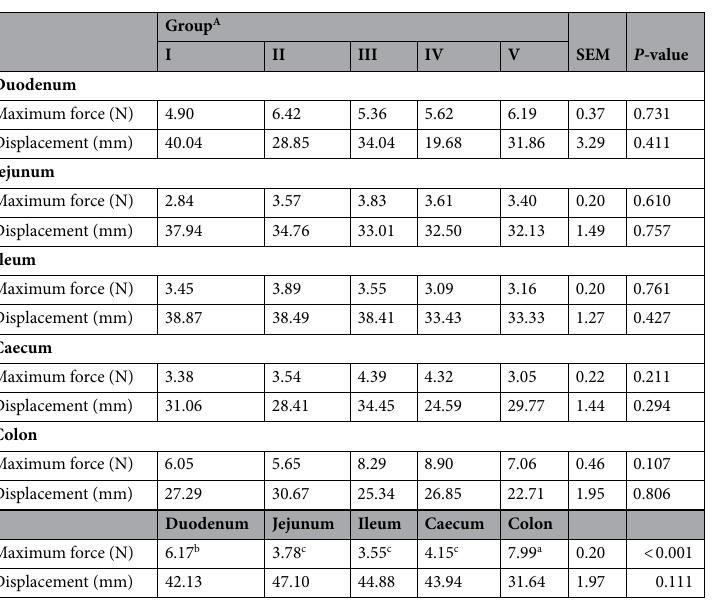
Table 4. Tensile strength of individual sections of the digestive system of broiler chickens. SEM standard error of the mean. a,b Values with different letters in a row differ significantly, P < 0.05. A Groups II, III, IV, V were fed with halloysite and zeolite (1:3 ratio) at 0,5% (1–35 days) and 1% (36–42 days) level. Aluminosilicates were also used for the litter: II—500 g of halloysite/m 2 ; III—250 g of halloysite/m 2 and 250 g of zeolite/m 2 ; IV—500 g of zeolite/m 2 ; V—130 g of halloysite/m 2 , 370 g zeolite/m 2 .